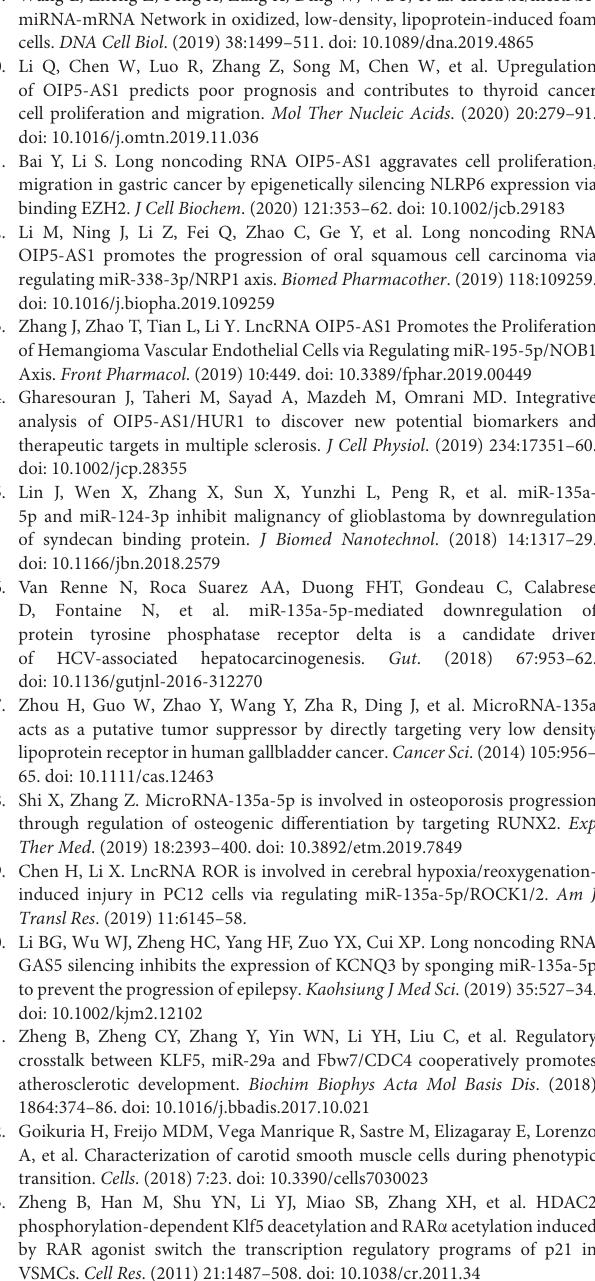
Supplementary Figure 3 | Effect of OIP5-AS1 knockdown on cell viability, apoptosis, migration, and expression of IL-6, TNF- α , and MDA in HUVECs. HUVECs were treated with control or ox-LDL or transfected with si-NC or si-OIP5-AS1, followed by the assessment of OIP5-AS1 expression by qRT-PCR (A) , cell viability by CCK-8 assay (B) , cell apoptosis by flow cytometry (C) , cell migration by Transwell assay (D) , Bax and Bcl-2 level by western blot (E) , and IL-6, TNF- α , and MDA levels by ELISA (F,G) . n = 3 independent biological replicates; error bars represented SD; ∗∗∗ P < 0.001, ∗∗∗∗ P < 0.0001 or NS: not significant by one-way ANOVA with Tukey’s post hoc test.